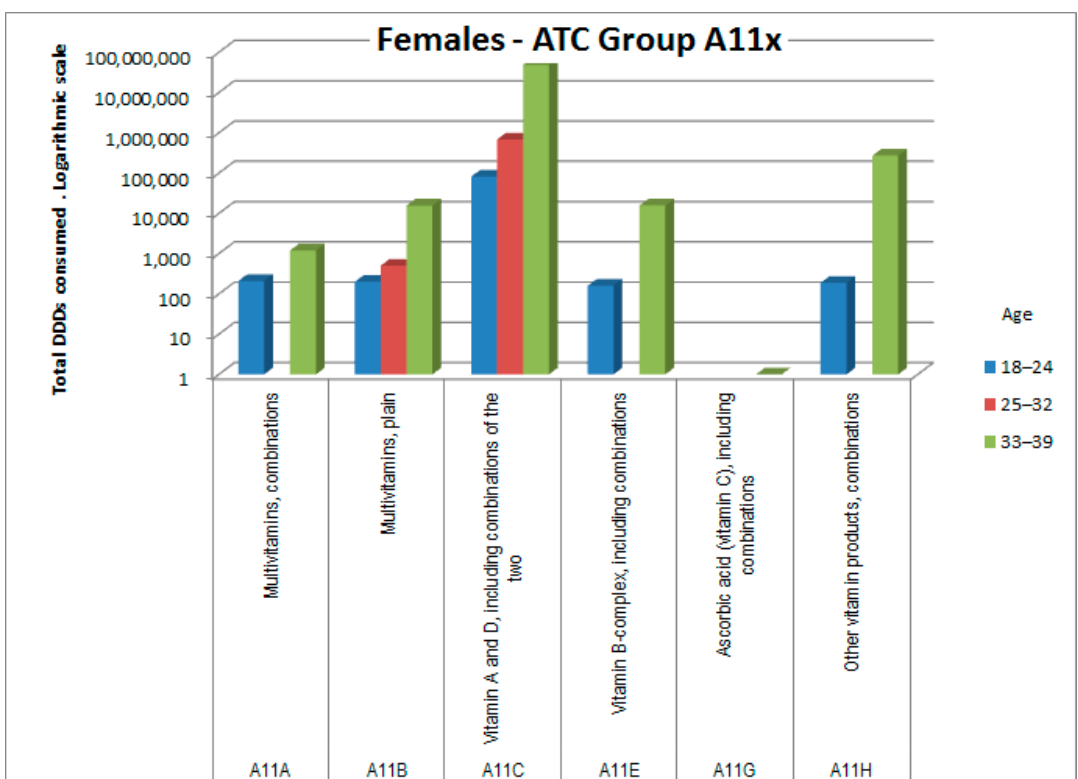
Figure 8. DDD consumption for females, ATC subgroup A11x (vitamins).